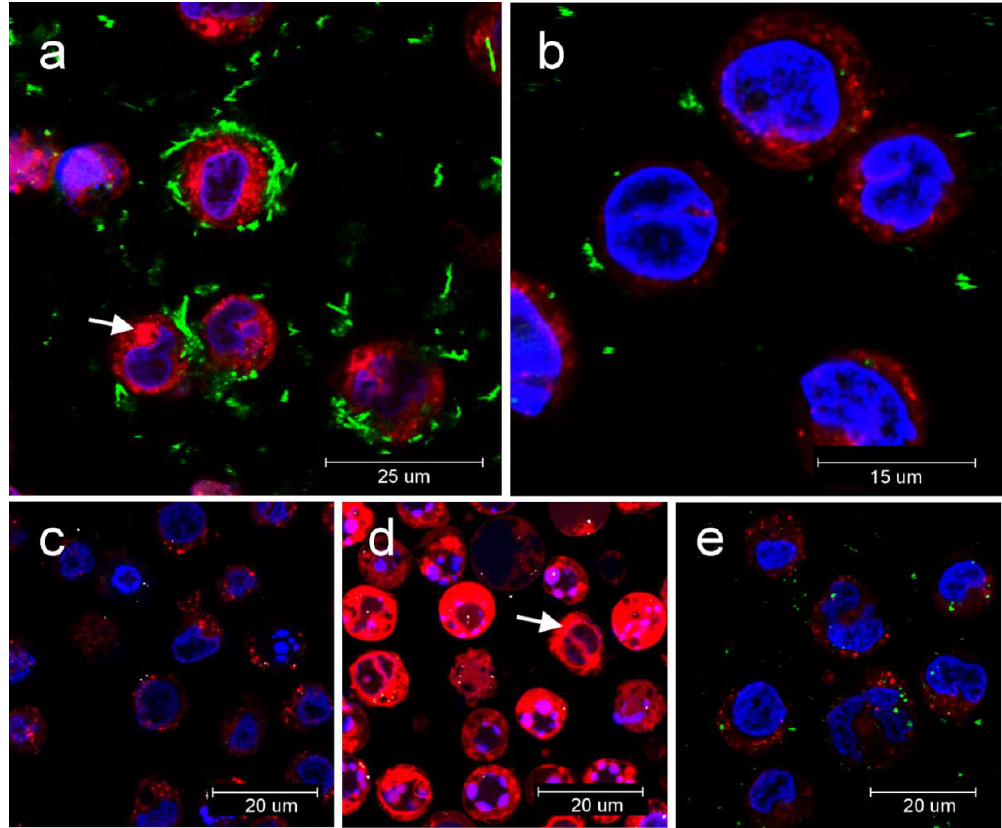
Figure 7. Release of cathepsin B from lysosomes into cytoplasm in THP1-null cell revealed by confocal microscopy: Proteolytic activity of cathepsin B was determined by fluorogenic substrate with red emission; ( a ) release of cathepsin B (red fluorescence) into cytoplasm after 24 h incubation with MWCNT (light scattering in green). Cytoplasm stained with fluorogenic substrate (white arrow); ( b ) Release of cathepsin B after 24 h incubation with GP2 (light scattering in green); ( c ) Negative control; ( d ) release of cathepsin B after incubation with lysosomal disruptor LLME with burst of cathepsin B into cytoplasm (white arrow); ( e ) release of cathepsin B after 24h incubation with GP1 (light scattering in